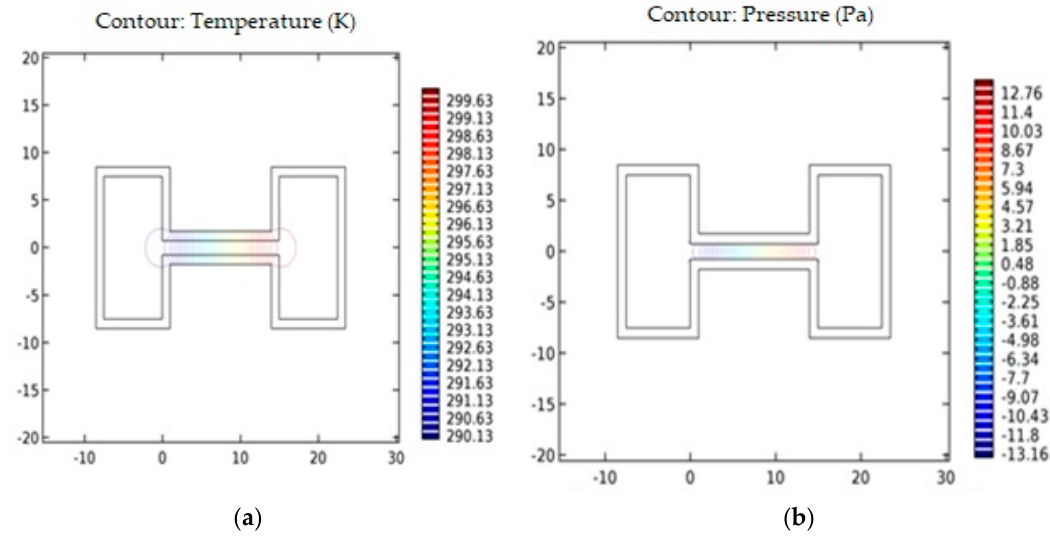
Figure 5. Contour diagram of ( a ) temperature vs. channel length; and ( b ) pressure vs. channel length.